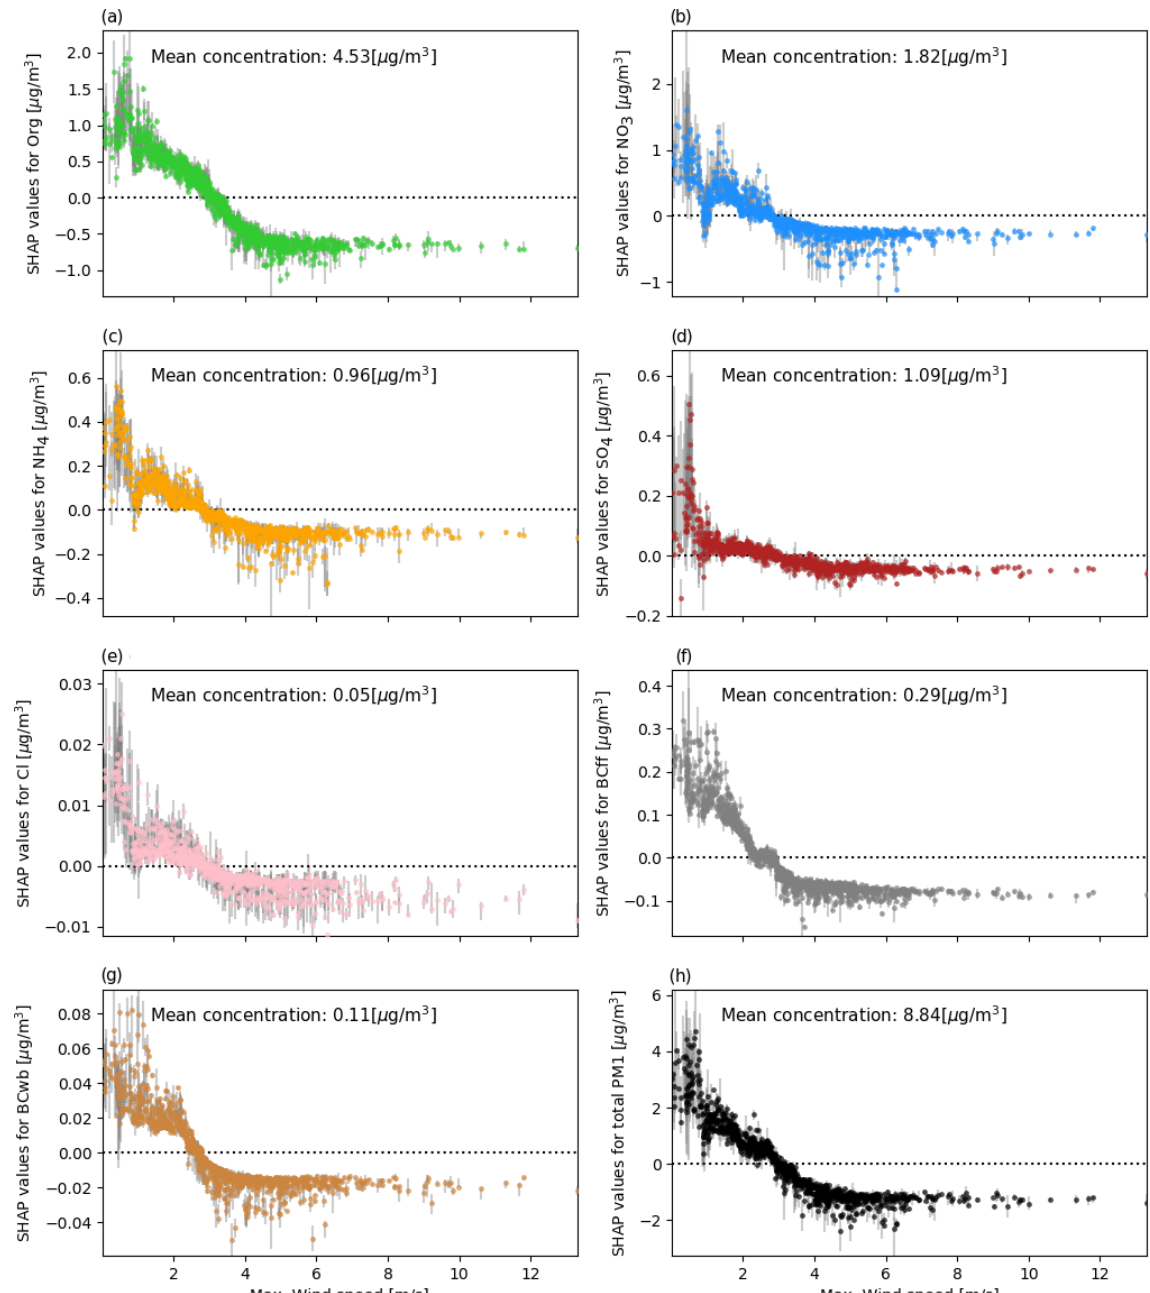
Figure B2. As Fig. 5 for the maximum wind speed SHAP values (contribution of maximum wind speed to the prediction of species and total PM 1 for each data instance) vs. absolute maximum wind